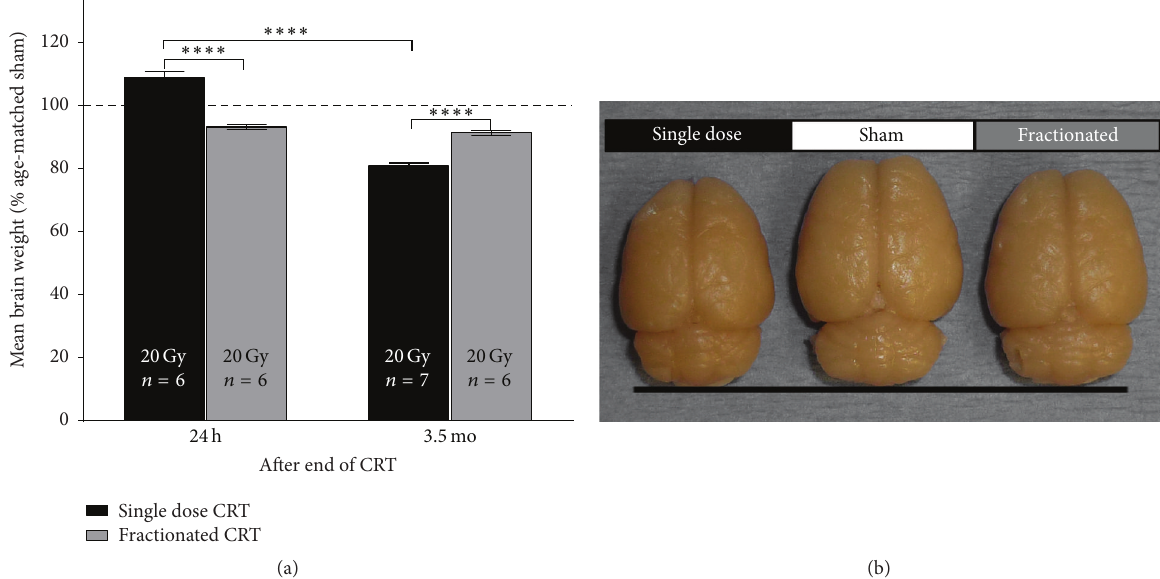
Figure 7: (a) Brain weights expressed as % of age-matched shams ( ± SEM) 24 h and 3.5 mo after end of CRT. The day after end of treatment, fractionated CRT significantly reduced brain weight by 6.5% compared to shams [ 𝑝 < 0.001 ]. Single dose CRT, however, significantly increased brain weight by 9.2% compared to shams [ 𝑝 < 0.01 ] and 15.7% relative to fractionated CRT [ ∗∗∗∗ 𝑝 < 0.0001 ]. 3.5 mo after end of treatment, fractionated CRT significantly reduced brain weight by 8.4% compared to shams [ 𝑝 = 0.0001 ] and 10.6% relative to single dose CRT [ 𝑝 < 0.0001 ] which reduced brain weight by 18.9% [ 𝑝 < 0.0001 ]. Mean brain weight of the single dose CRT group was reduced 28.1% at 3.5 mo relative to 24 h [ 𝑝 < 0.0001 ]. (b) Representative images of a brain from each group 3.5 mo after radiation highlight the radiation-induced stunting of brain size visible even to the naked eye (figure originally published in